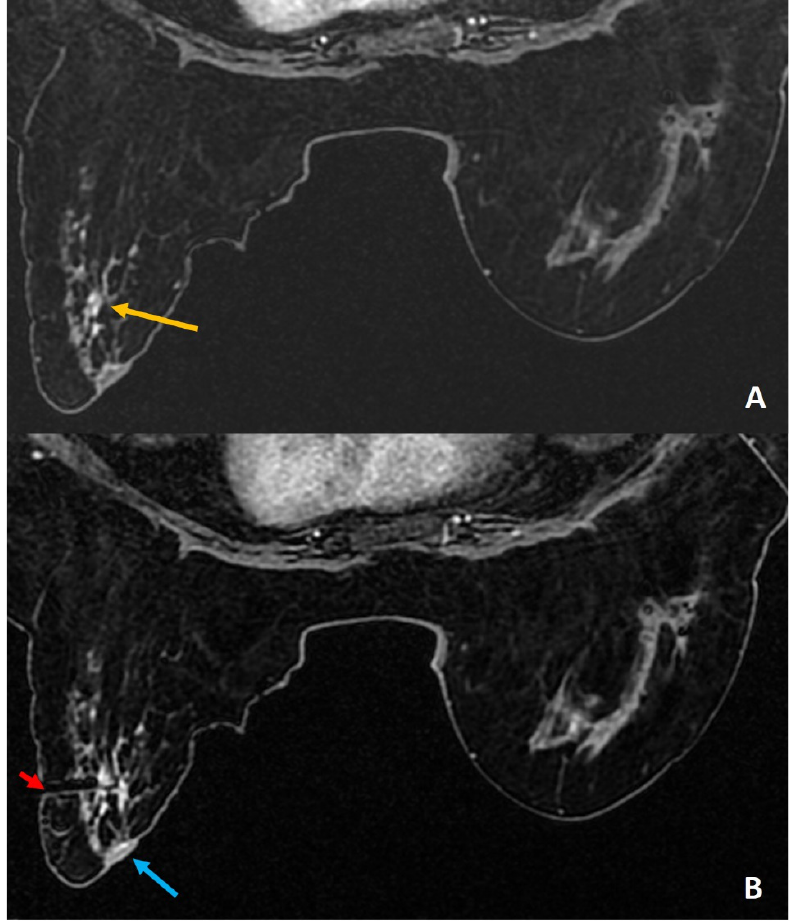
Figure 5. ( A ). High-risk screening MRI reported clumped linear non-mass enhancement (yellow arrow) in the left retroareolar region. ( B ). During biopsy, rolling of the breast with nipple directed away (blue arrow) from the skin entry (red arrow) could help to avoid injury to the areola. The histology was reported as atypical ductal hyperplasia.